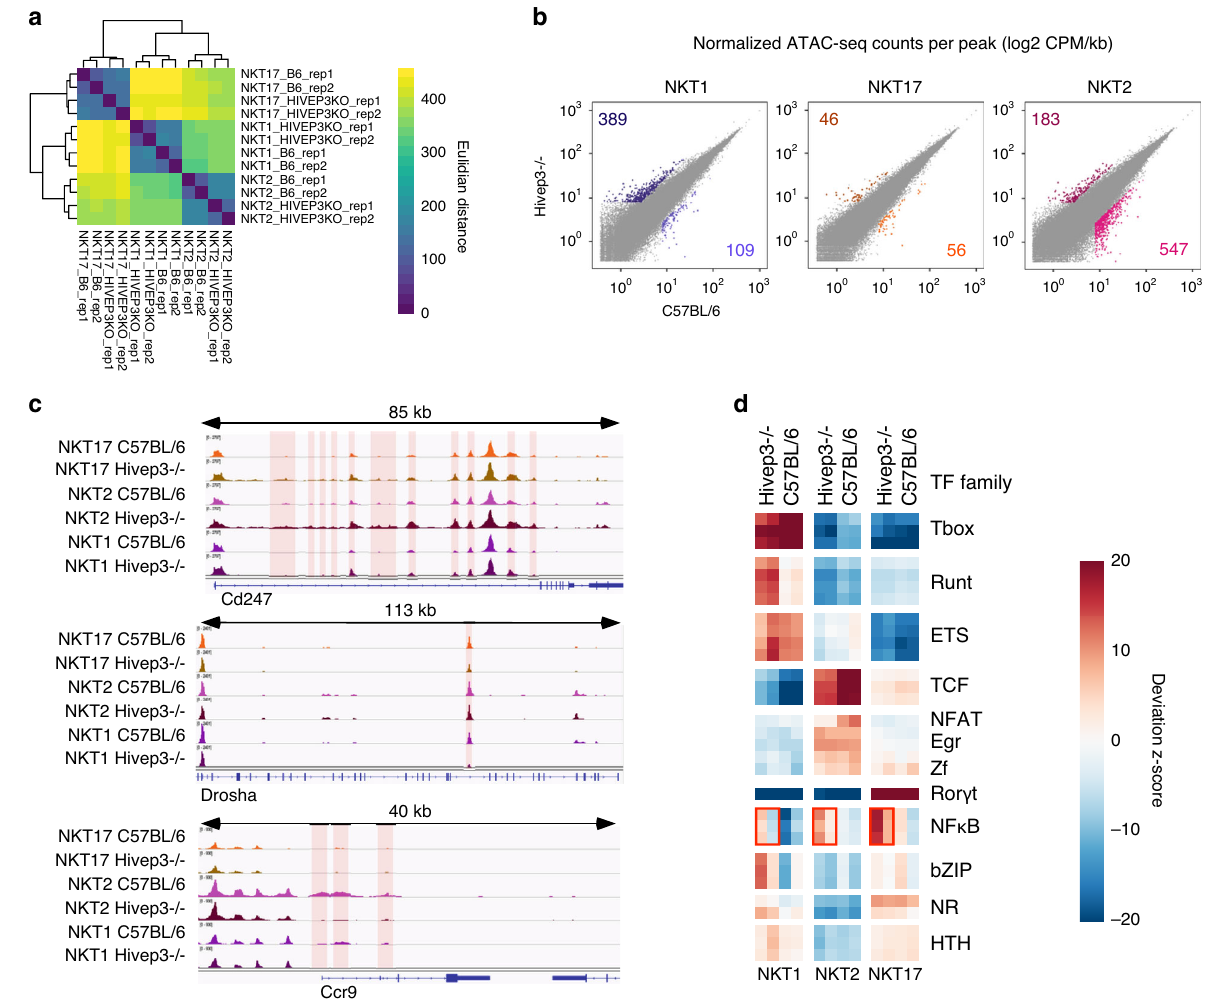
Fig. 7 Hivep3 de fi ciency impacts the chromatin landscapes of thymic iNKT cell subsets. a Euclidean distance values were computed for the iNKT1, iNKT2 and iNKT17 ATAC-seq samples from both C57BL/6 and Hivep3 − / − mice. b Scatterplots of mean ATAC-seq counts per peak comparing iNKT1, iNKT2 and iNKT17 subsets between C57BL/6 and Hivep3 − / − mice. c Mean ATAC-seq coverage at the Cd247 , Drosha and Ccr9 loci in all samples is depicted. Differentially accessible loci are highlighted in red. d Motif enrichment for iNKT1, iNKT2 and iNKT17 subsets across both strains within the differentially accessible regions is depicted as a heatmap. NF- κ B binding motifs are enriched in the differentially accessible regions in the Hivep3 − / − samples and this is indicated with red